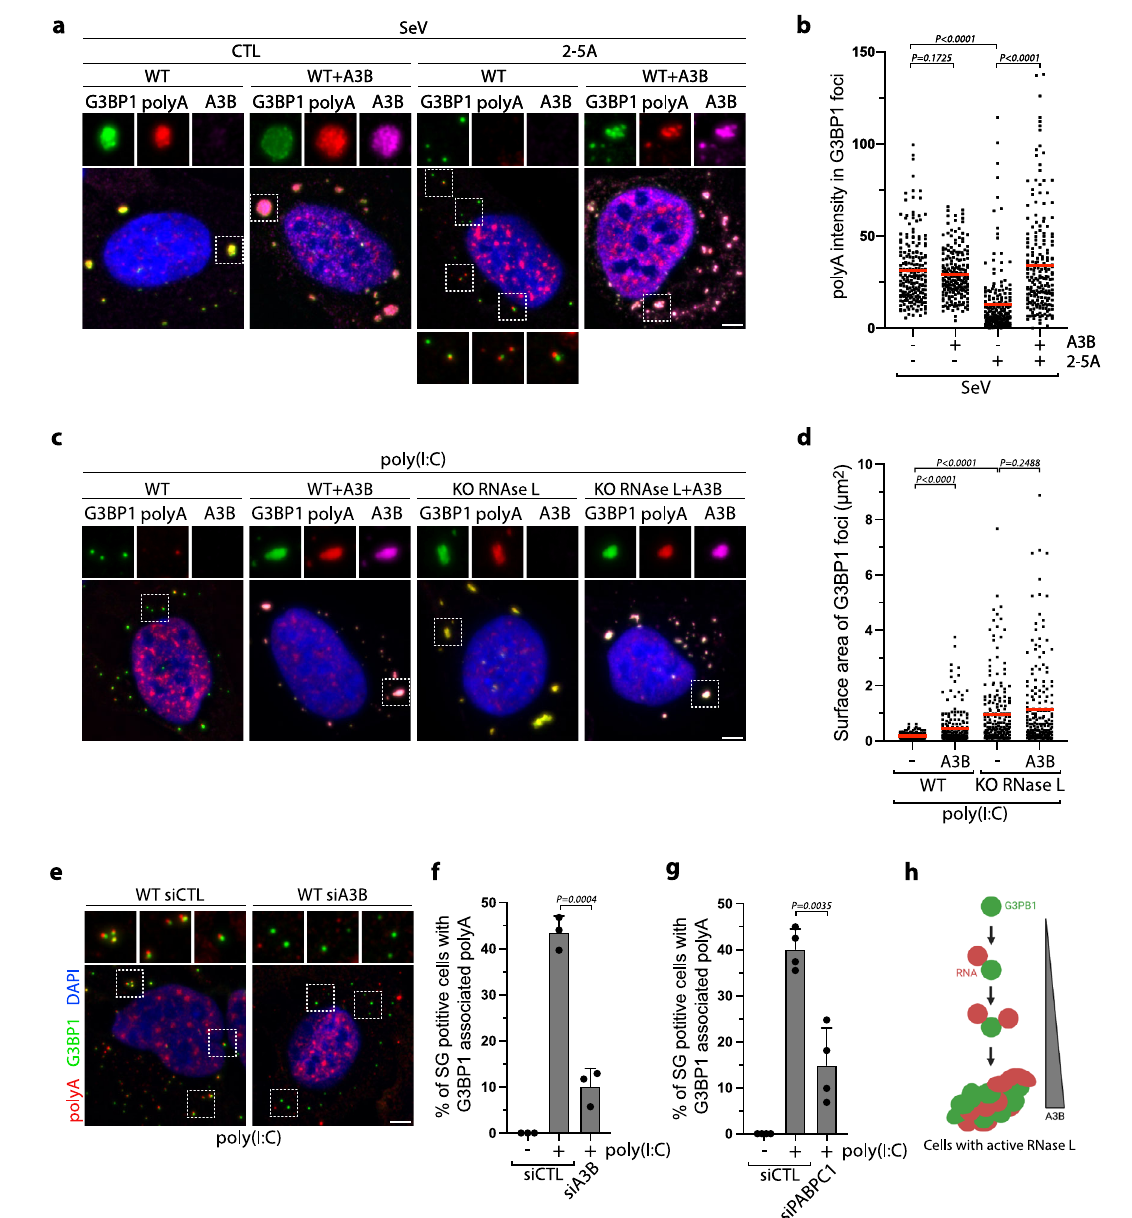
Fig. 9 | APOBEC3B counteracts RNAse L from limiting G3BP1-RNA condensate. a U2OS-A3B- fl agcells±DOXweretransfectedwith2 – 5A(20 µ M)8haftercellswere infected with SeV (MOI=1). At 24hpi, G3BP1, poly(A), and A3B localization were monitored by sequential IF-FISH. Scale bar: 5 μ m. b Quanti fi cation of poly(A) intensity (arbitrary units) in G3BP1 foci from the experiment described in ( a ). Red lines indicate the mean (Number of G3BP1 foci, n =200). P -values were calculated withatwo-tailedWelch t -test. c LocalizationofG3BP1,poly(A),A3Bweremonitored by sequential IF-FISH after poly(I:C) transfection (200ng/mL, 16h) in U2OS-A3B- fl agand U2OS-A3B- fl ag-RNase L KO cells ±DOX. Scalebar: 5 μ m. d The surfacearea of G3BP1 foci was quanti fi ed following poly(I:C) (200ng/mL, 16h) transfection of